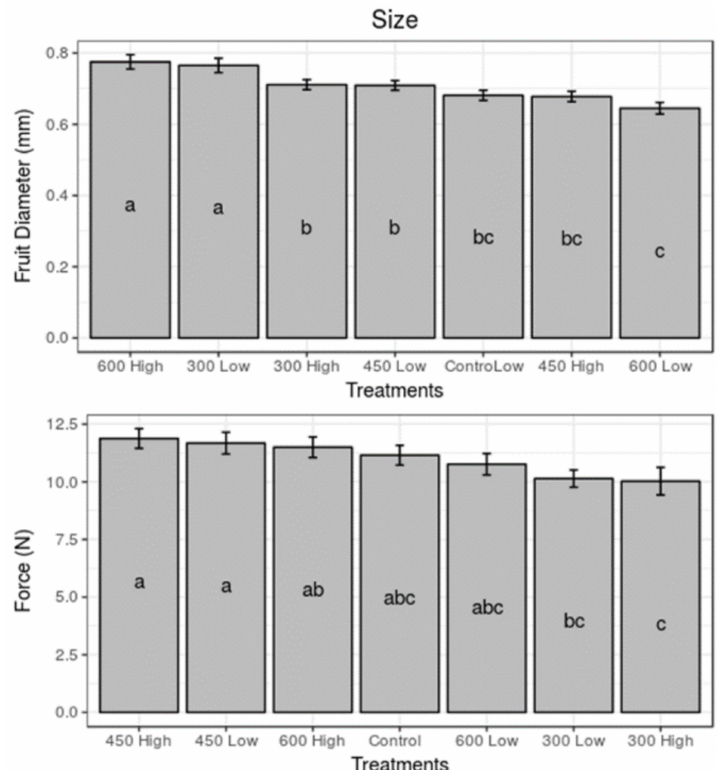
Figure 3. Fruit size (diameter) and firmness of tomatoes cultivated in the standard (control) biochar amended media. Bars represent standard error ( n ≈ 30). Different letters show significant difference ( p < 0.05) between